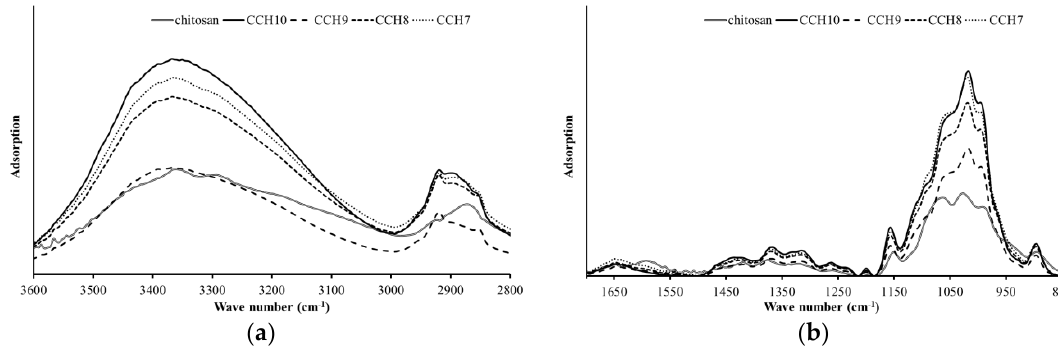
Figure 3. FT-IR spectra of the CCH films in the range of 3600 to 2800 cm -1 ( a ) and 1700 to 850 cm -1 ( b ).